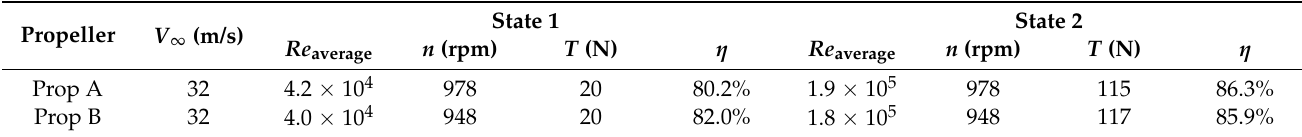
Table 7. Performances of two optimized propellers at the states with different Reynolds